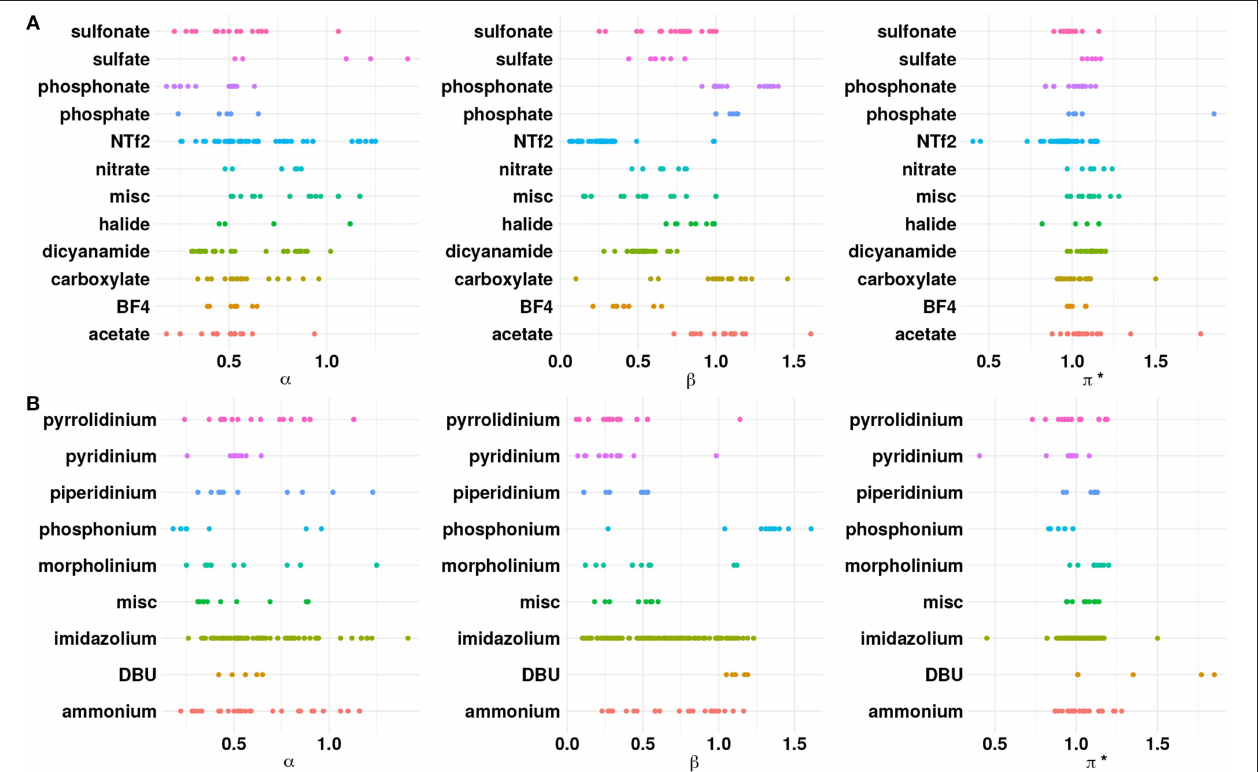
FIGURE 1 | Dot plots of α , β , and π * with respect to the (A) anions and (B) cations. The “misc” category for anions includes phosphite, perchlorate, tricyanomethanide, thiocyanate, PF 6 , SbF 6 , and dimethoxy(oxo)phosphanuide. The “misc” category for the cations includes pyrazolium, octanium, sulfonium, and